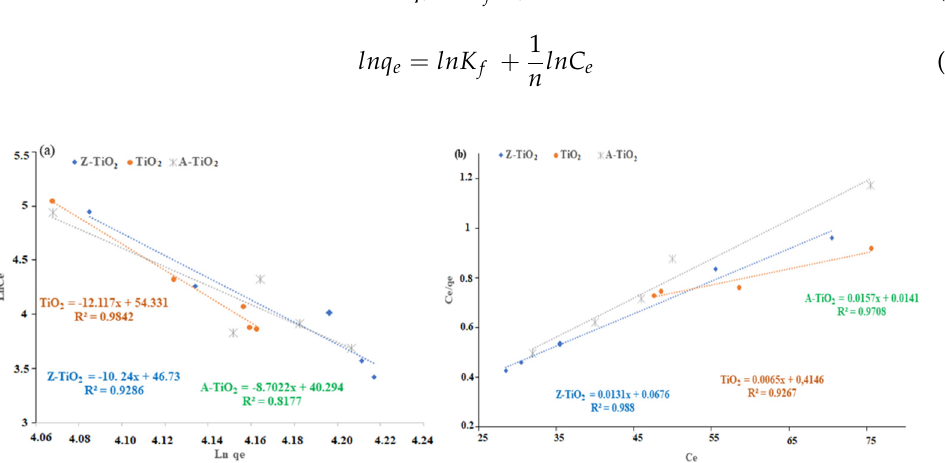
Figure 9. Freundlich ( a ) and. Langmuir ( b ) adsorption isotherms for the degradation of COD (367.7 mg/L) using 4 g of Z–TiO 2 > A–TiO 2 > TiO 2 . (367.7 mg/L) using 4 g of Z–TiO 2 > A–TiO 2 > TiO 2